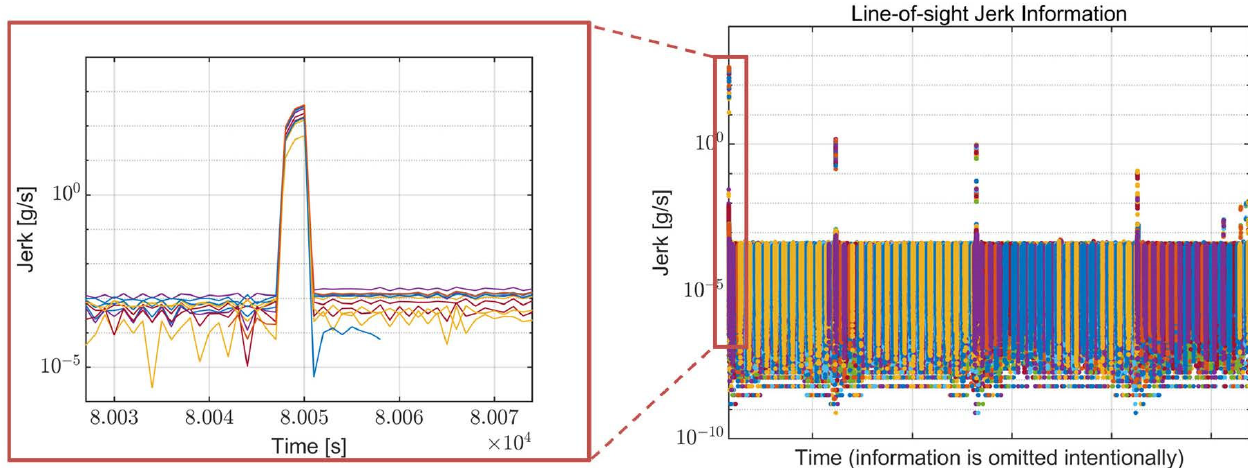
Figure 4. LOS jerk information of the Moon exploration spacecraft during the mission trajectory. Each color in the figure indicates a different GPS satellite.